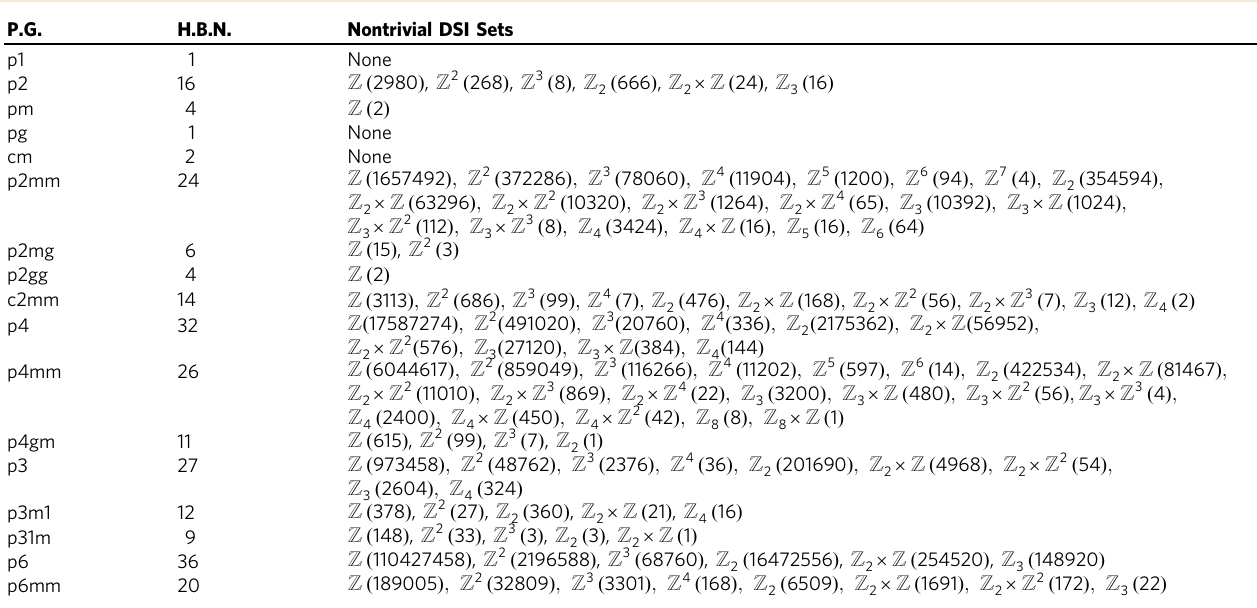
Table 1 Numbers of Hilbert bases and nontrivial DSIs for all spinless 2D plane groups. P.G.